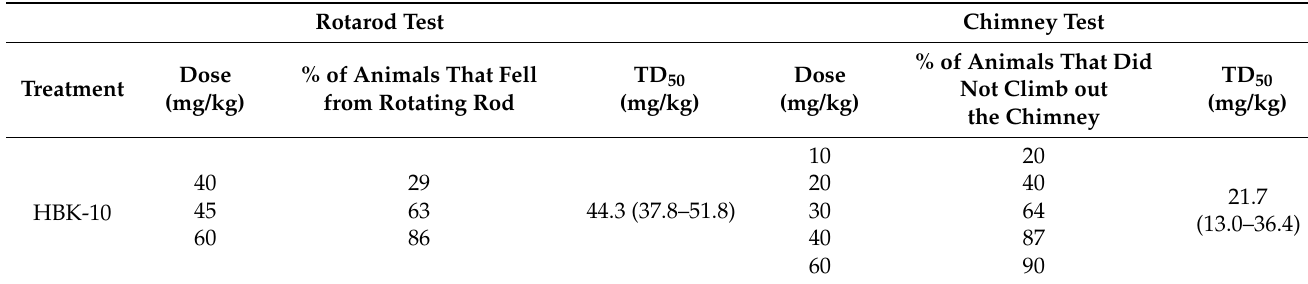
Rotarod: After three days of training, the studied compound was administered ip 30 min before the test. The results are presented as the percentage of animals that could not stay on a rotating rod for at least 1 min. Chimney test: After a training session, the